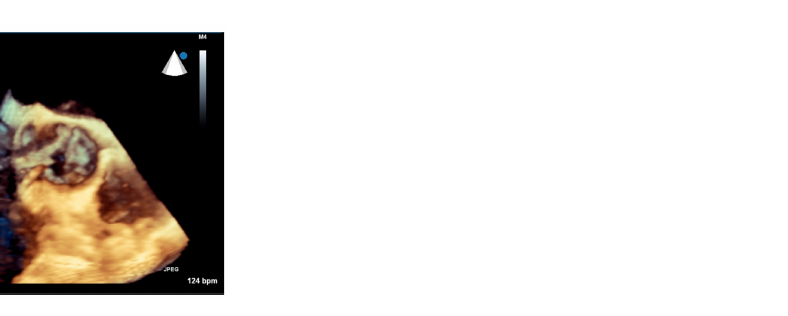
Figure 4. Three-dimensional reconstruction of transesophageal echocardiogram mid-esophageal aortic valve short-axis view demonstrating aortic valve destruction with a large hole in the center.